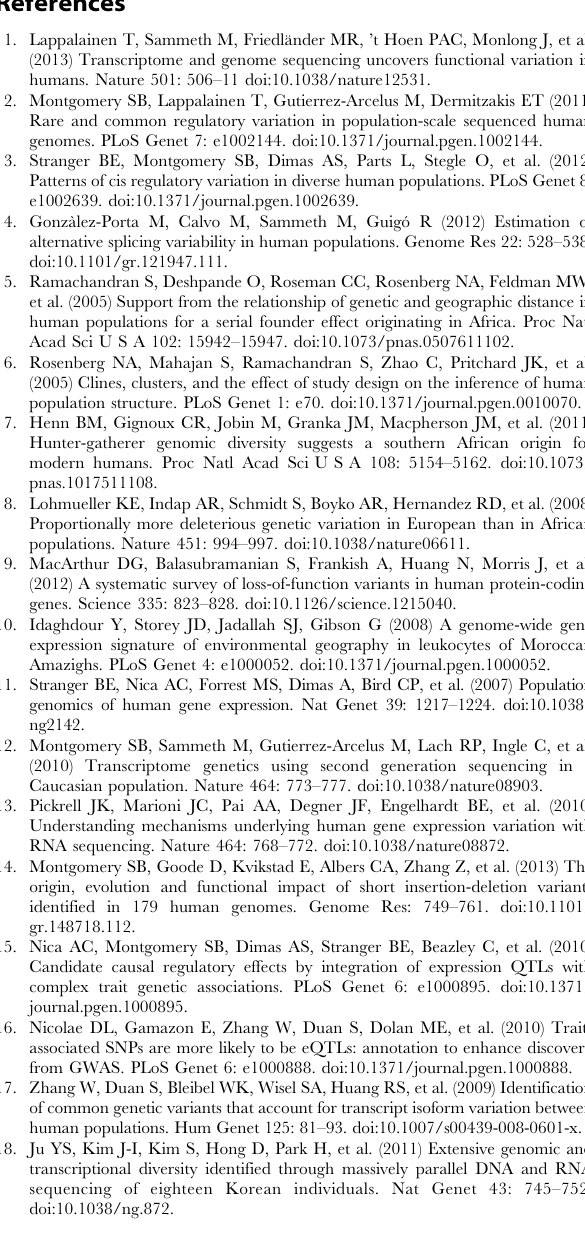
Figure S19 Tests for differential splicing across pairwise HGDP populations using the Anderson method developed in Gonzalez- Porta et al. Grey dashed lines indicate the expected null p-value distribution under the null hypothesis. Table S1 Differentially spliced exons. Significant at the FDR , 5% threshold. FC is fold change, CPM is counts per million, and LR is likelihood ratio. Table S2 Differentially spliced transcripts. Significant at the FDR , 5% threshold. FC is fold change, CPM is counts per million, and LR is likelihood ratio. Table S3 Novel transcribed region metrics across